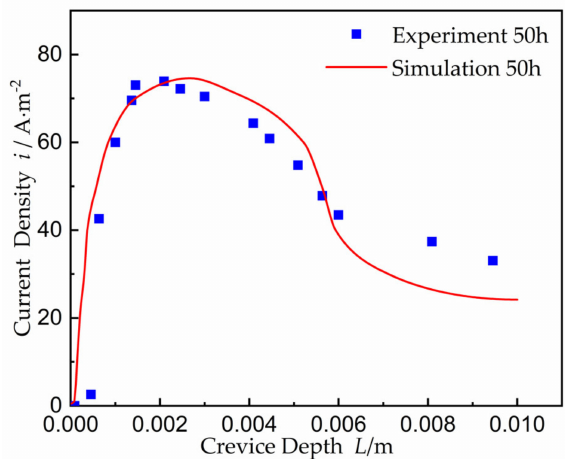
Figure 9. Distribution of current density at time 50 h.